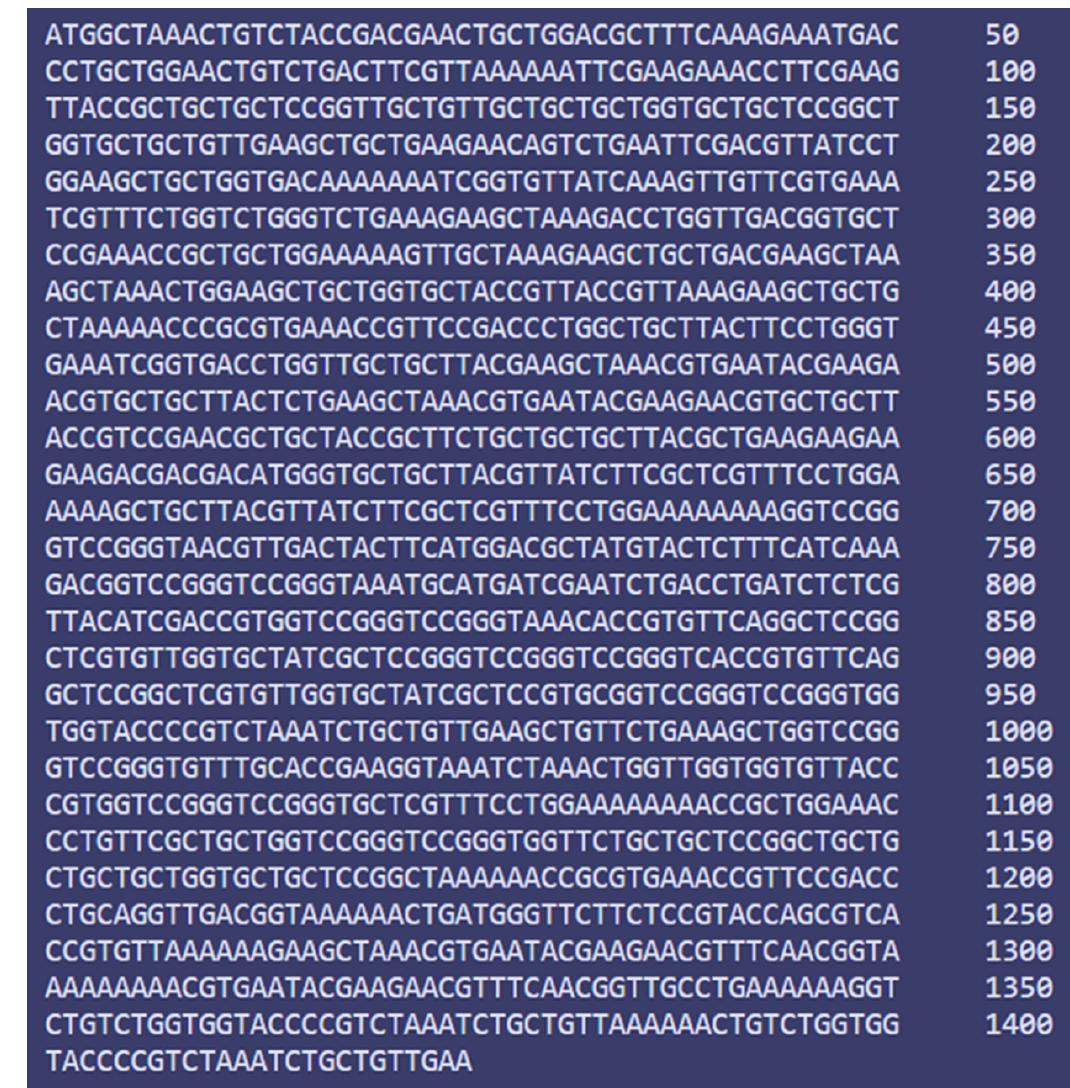
Figure 14. The vaccine was cloned into the pET − 28a (+) vector.